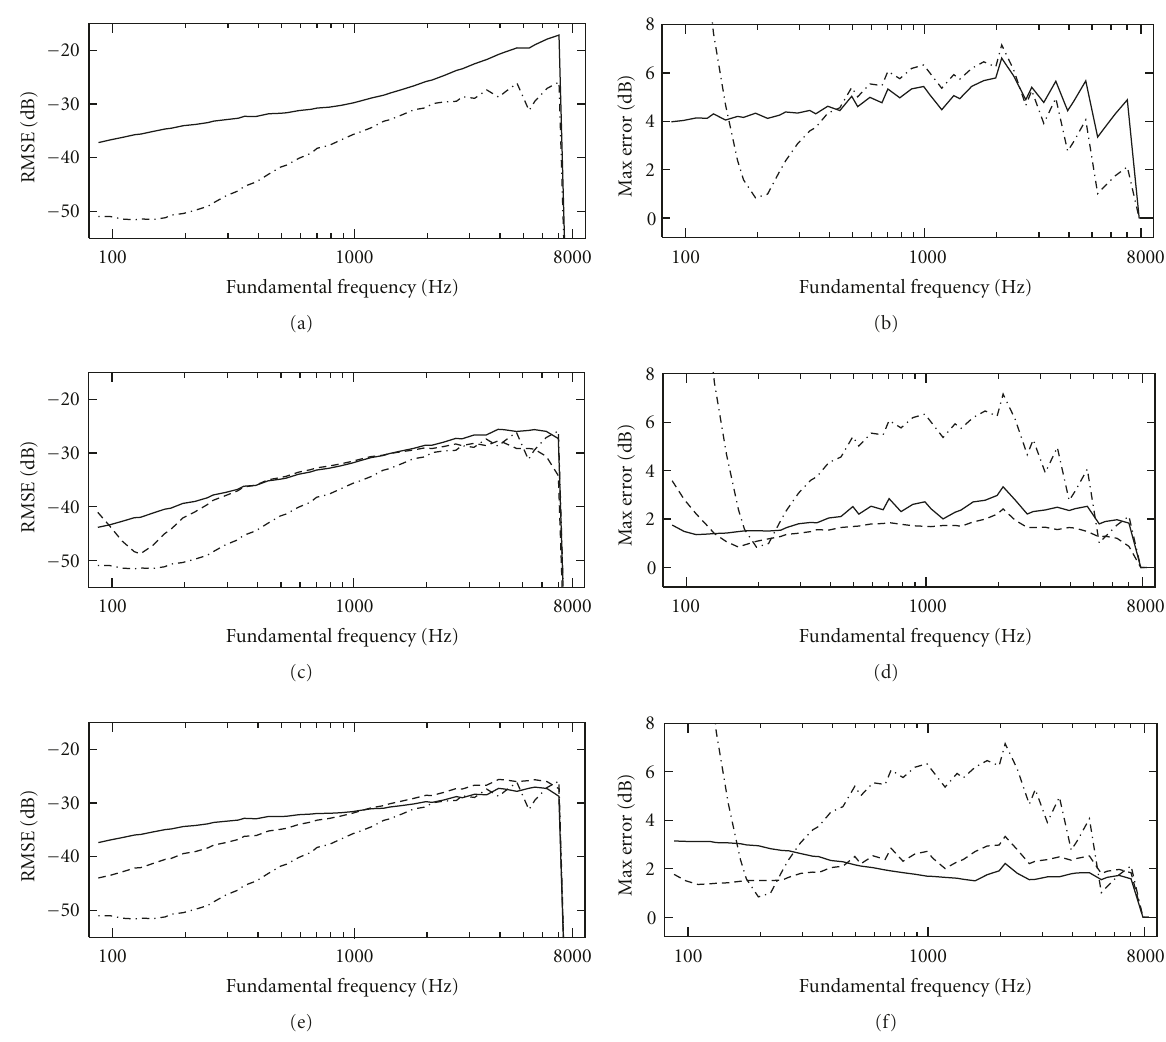
Figure 12: Root mean squared error (RMSE) and the maximum absolute harmonic magnitude error of the filtered (a), (b) the ideally bandlimited oscillator (solid line), (c), (d) the third-order B-spline BLIT (solid line) and the fourth-order B-spline BLEP (dashed line) oscillator, and (e), (f) the second- (solid line) and fourth-order (dashed line) DPW oscillator outputs, respectively. The dash-dotted line in all plots represents the corresponding error of the phase distortion model.